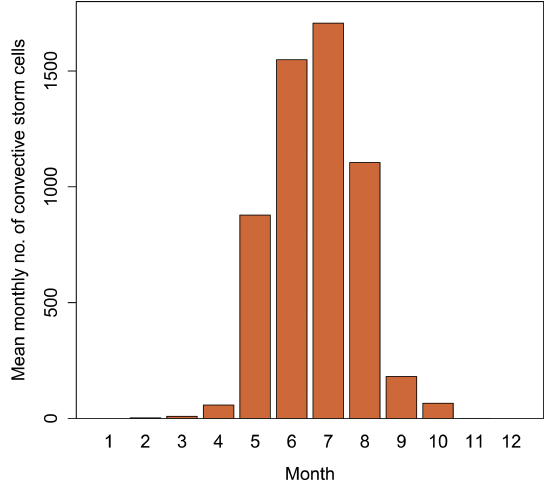
Figure 4. Monthly distribution of the mean number of convective storm cells in the Prut River basin, for the period 2003–2017.